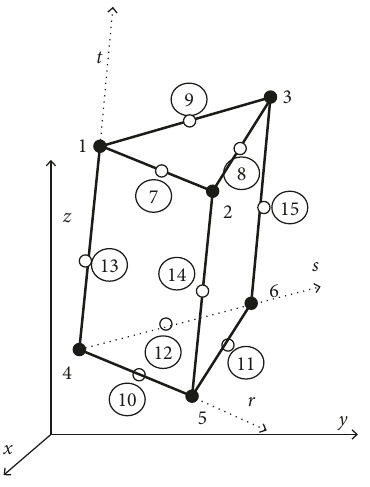
Figure 10: The CCIsoWedge solid elements used in the finite element